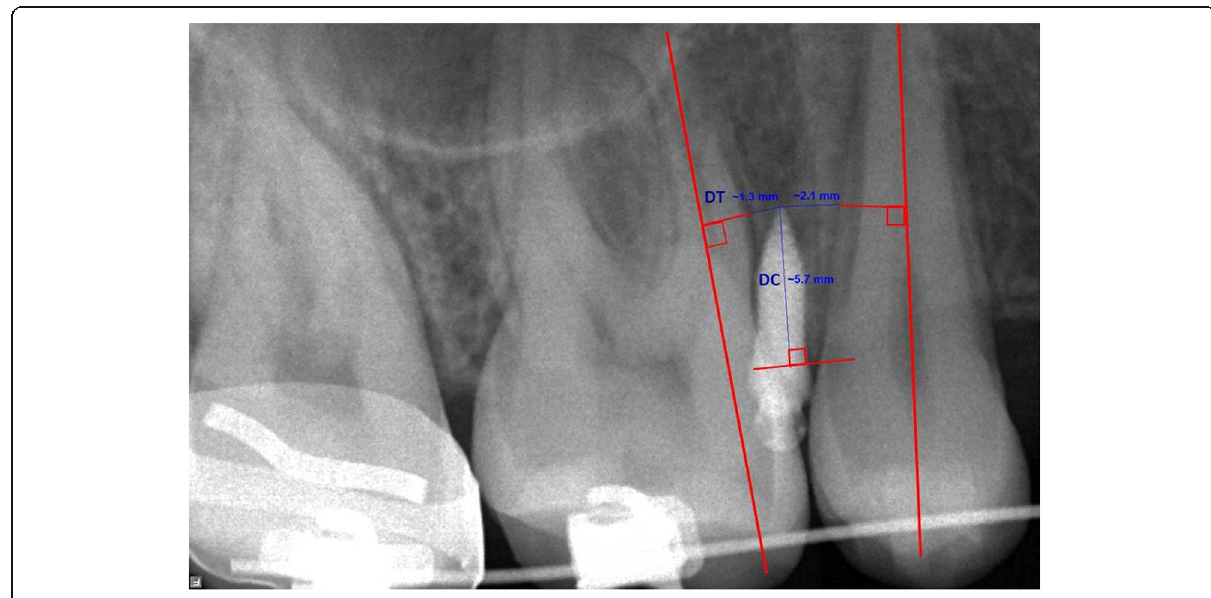
Fig. 1 Radiographic evaluation using a periapical